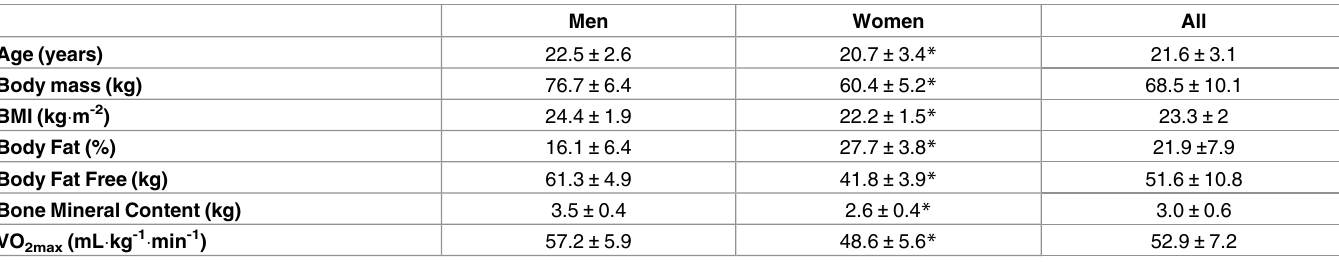
Table 1. Subjects characteristics (mean ±